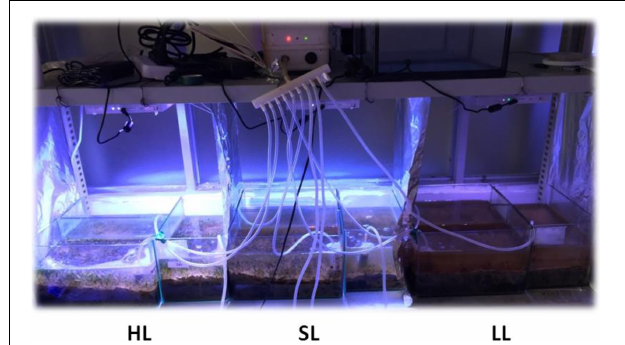
FIGURE 2 | Experimental set-up of the laboratory treatments. SL represents the control saturating light (200 µ mol photons/m 2 /s); LL represents low light (20 µ mol photons/m 2 /s); and HL represents high light (600 µ mol photons/m 2 /s). SL and HL were in the optimal light range between the minimum saturating light and the minimum inhibiting light.